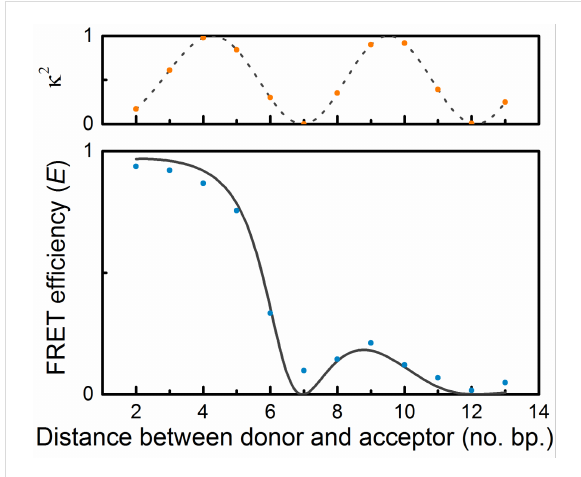
Figure 5: Example of typical FRET efficiency as a function of number of base pairs separating the donor and acceptor (data, blue dots, is an average of steady-state and time-resolved measurements of the FRET pair qAN1 and qA nitro ). The line shows a curve fitted to the data based on FRET theory. The top graph shows how the orientation factor, κ 2 , varies with number of base pairs separating the donor and